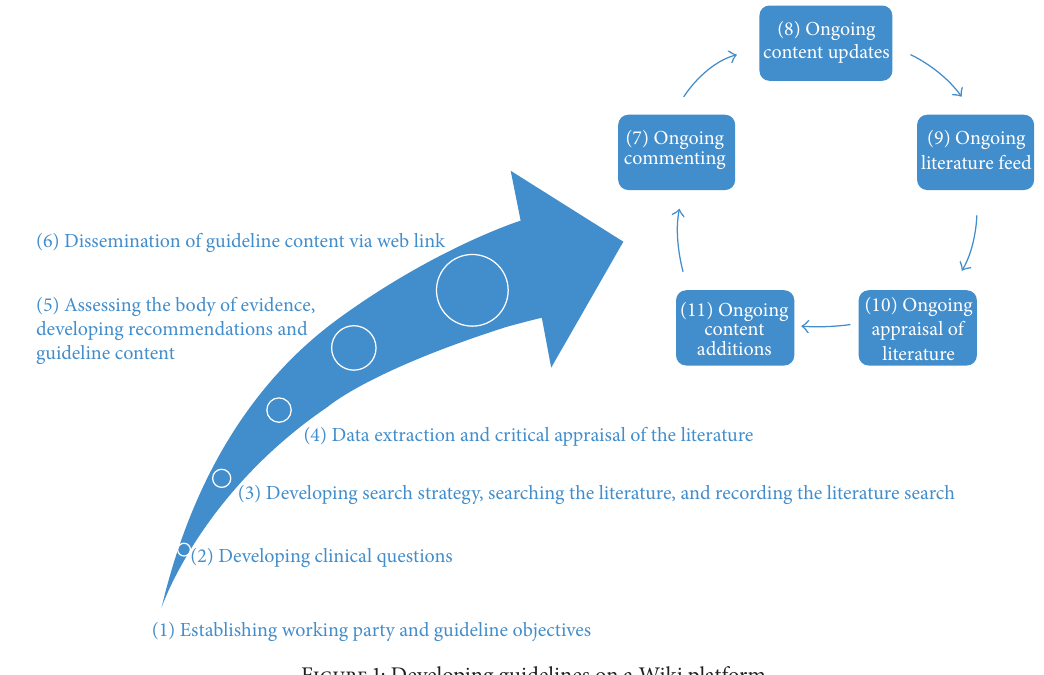
Figure 1: Developing guidelines on a Wiki